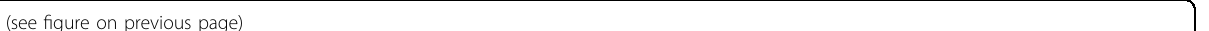
(see fi gure on previous page) Fig. 3 Nr2f6 − / − OT-I CD8 + memory T cells display enhanced effector cytokine responses upon secondary infection, despite no alterations in the memory phenotype. A Schematic overview of secondary infection. Congenic mice were reconstituted with either CD45.2 + OT-I Nr2f6 + / + or Nr2f6 − / − T-cells and infected with 10 4 CFU LmOVA and were re-infected > 200 days with 2 × 10 5 CFU LmOVA (d0). Spleens were harvested on d3 after second infection and analyzed. B Representative dot plots, frequencies, and total cell numbers per spleen of memory T-cell subsets based on differential surface expression of CD27 and CD43 gated out of transferred OT-I. C Total number of OT-I cells per spleen. D Representative dot plots of IFN- γ + production within splenic OT-I at day 3 post LmOVA re-infection after N4 recall ex vivo for 4 h, in the presence of Brefeldin A. Frequencies of IFN- γ within CD27 + CD43 − and CD27 − CD43 − memory populations, as well as total OT-I and IFN- γ producing cells per spleen. E Quanti fi cation of MPEC frequencies (CD127 + KLRG1 − ), frequencies, and total cell numbers of central memory (Tcm) CD44 + CD62L + and effector memory (Tem) CD44 + CD62L − OT-I T cells. F Frequencies of live (7-AAD - AnnexinV − ), and Bcl-2 + OT-I T cells in the blood over time at indicated days after second LmOVA infection. G Representative dot plots of transcription factors T-bet and Eomes, in Nr2f6 + / + or Nr2f6 − / − OT-I. Gating is based on FMO controls. Quanti fi cation of % T-bet + Nr2f6 + / + or Nr2f6 − / − splenic OT-I is shown. H Representative histograms (T-bet) and quanti fi cation of T-bet MFI together with total cell numbers in Nr2f6 + / + or Nr2f6 − / − OT-I T cells. Representative data are shown from one independent, out of at least two replicative experiments, with n = 3 – 4 per group and experiment. Each dot represents the data of an individual mouse. Results are shown as mean ± SD. An asterisk indicates statistically signi fi cant differences between genotypes calculated using Student ’ s t test, mixed-effects model (REML) ( F ), or two-way ANOVA ( E ). A p value < 0.05 was considered statistically signi fi cant. * p < 0.05; ** p < 0.01. All OT-I T cells are gated as CD45.2 + CD45.1 − CD8 + CD44 + OVA tet +